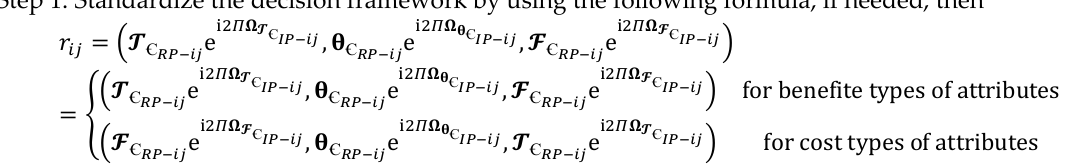
for cost types of attributes